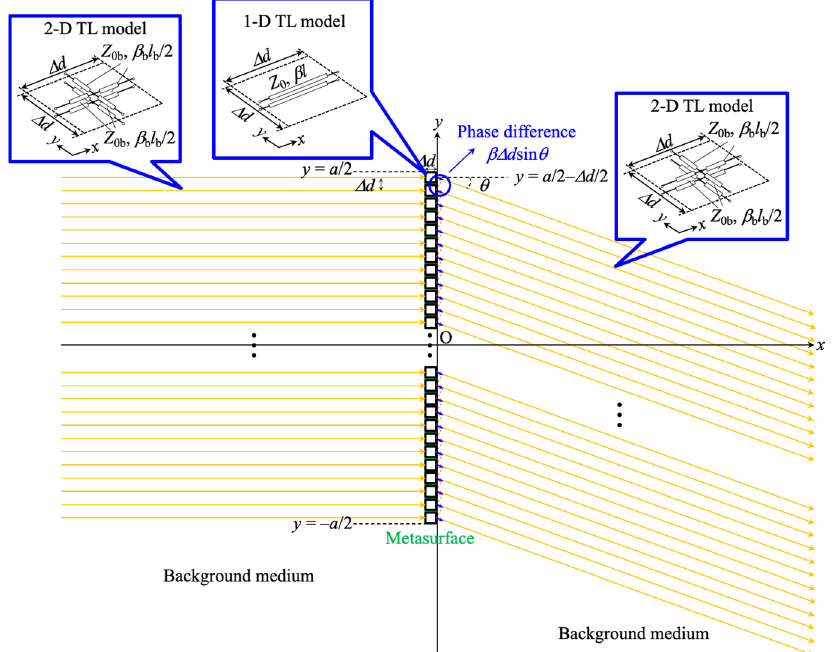
Figure 1. The concept of a broadband metasurface for refracting normal incident plane waves with an angle of θ . The size is a × ∆ d and the area is discretized with the 1D TL model whose size is ∆ d × ∆ d . The 2D TL model whose size is ∆ d × ∆ d is used for the acoustic metasurface and the background medium. Z 0b and Z 0 are the characteristic impedances and β b l b and β l are the electrical lengths.